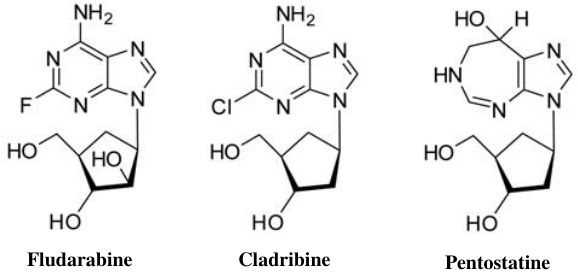
Figure 3. Structures of fludarabine, cladribine and pentostatine